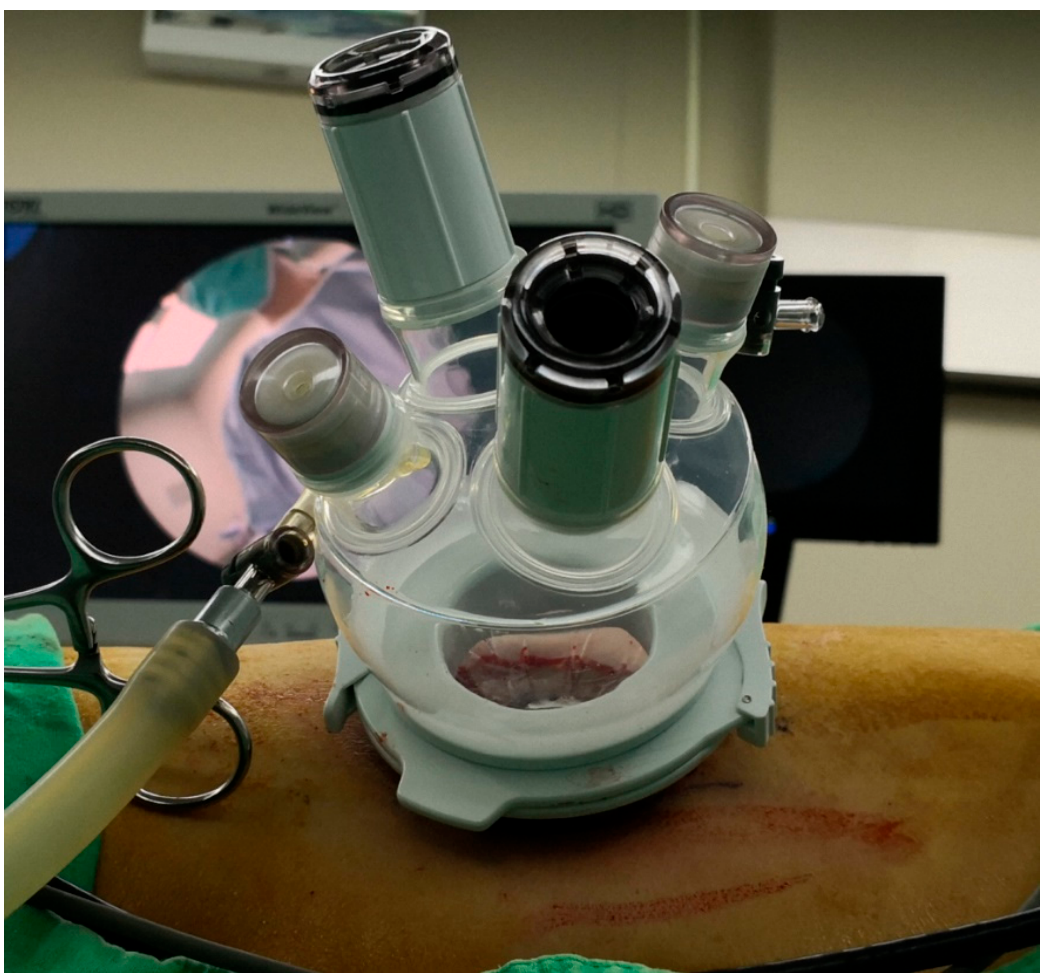
Figure 2. Placement of the LagiPort trocar.